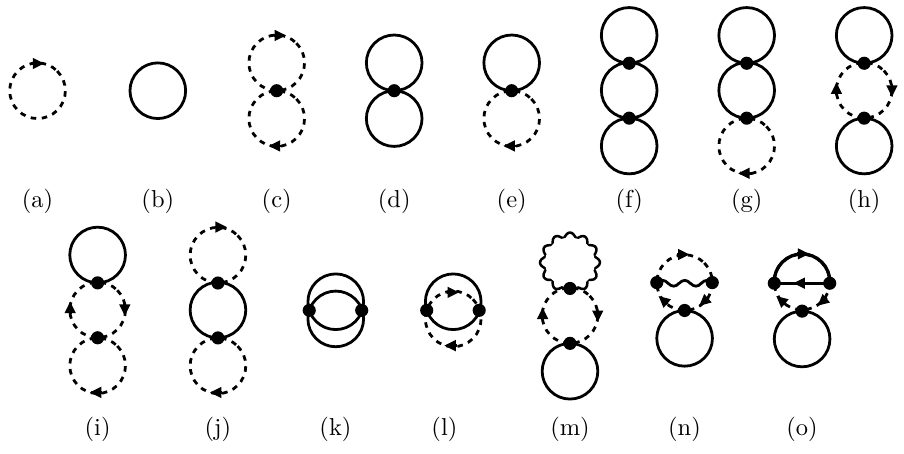
Figure 7 . Diagrams contributing to p singlet . Dashed (solid) lines denote the Higgs (singlet), wiggly E line gauge fields and the solid arrowed line the top quark. Vertices in these diagrams are bare vertices, i.e. in renormalised perturbation theory there are counterterm contributions in (a)-(e).